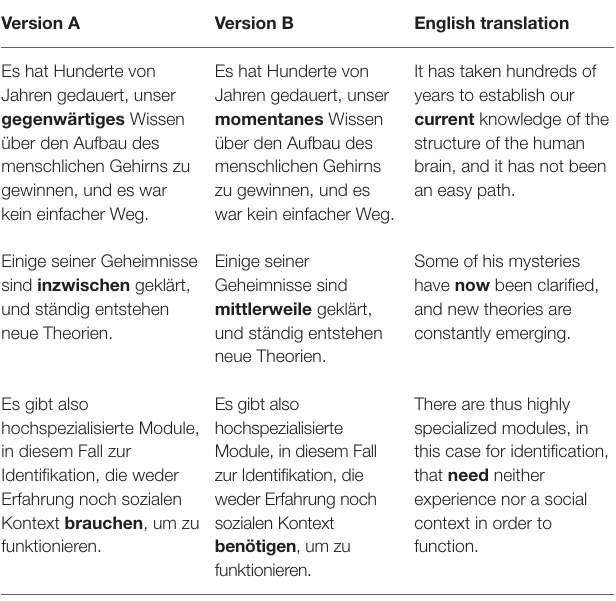
TABLE 1 | Example sentences with the replacement of one single non-central word (printed in